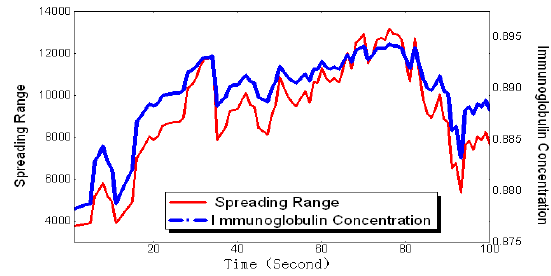
Fig.6. Malicious Applet spreading range and corresponding immunoglobulin concentration